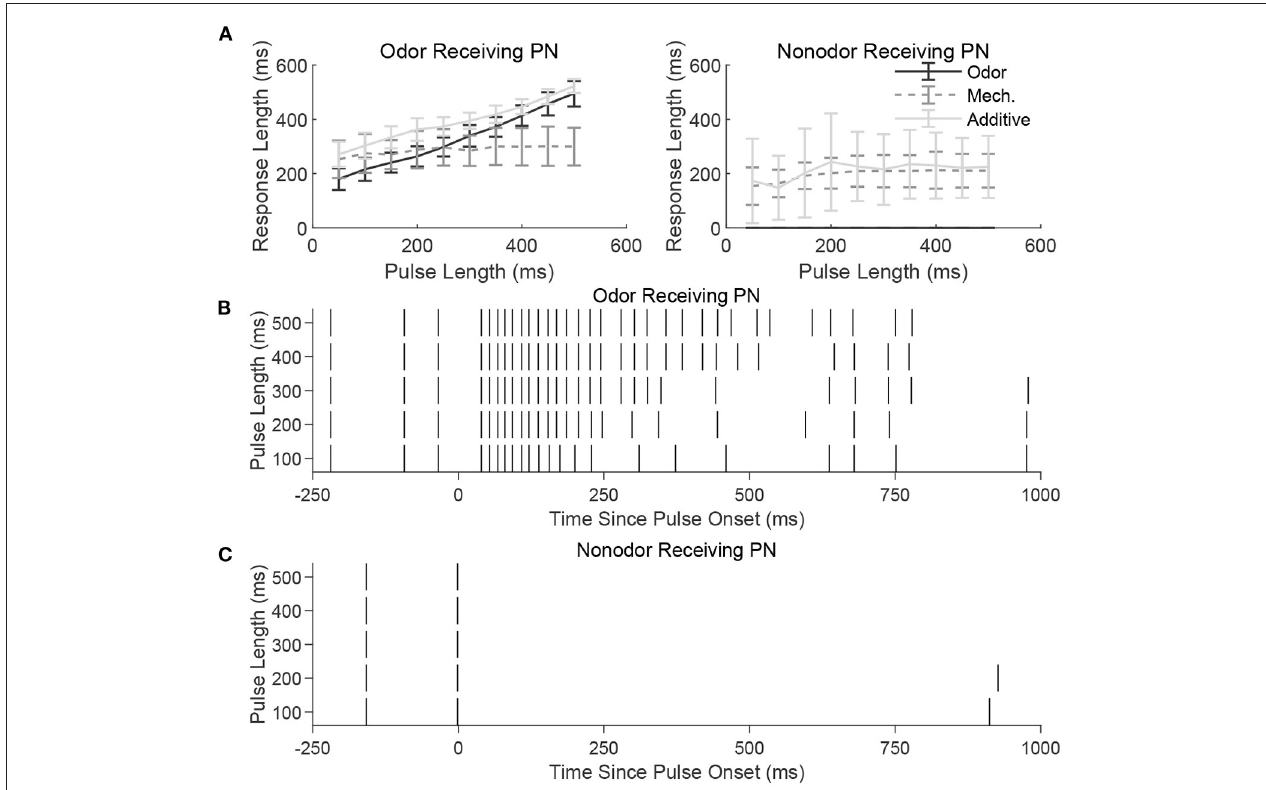
FIGURE 3 | (A) Length of spiking response vs. stimulus pulse length for an odor receiving PN (left) and a nonodor receiving PN (right) in the three stimulus scenarios (odor only, mechanosensory only, and additive sensory integration). Responses are averaged over 50 trials. Note that in the presence of odor (odor only and